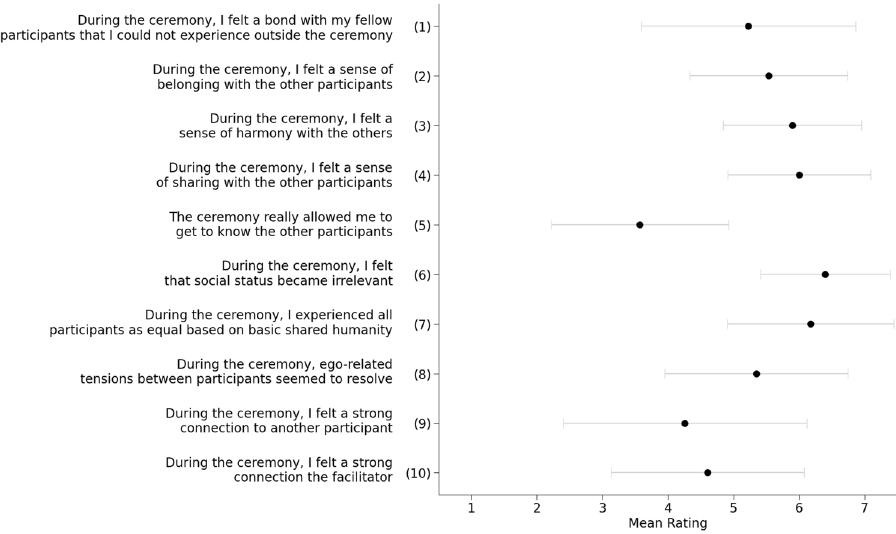
Figure 7. Mean ratings for the 8 items in the Communitas questionnaire (items 1–8), and two additional items relating to connection with another participant and with the facilitator (items 9 & 10), with ± 1 SD error